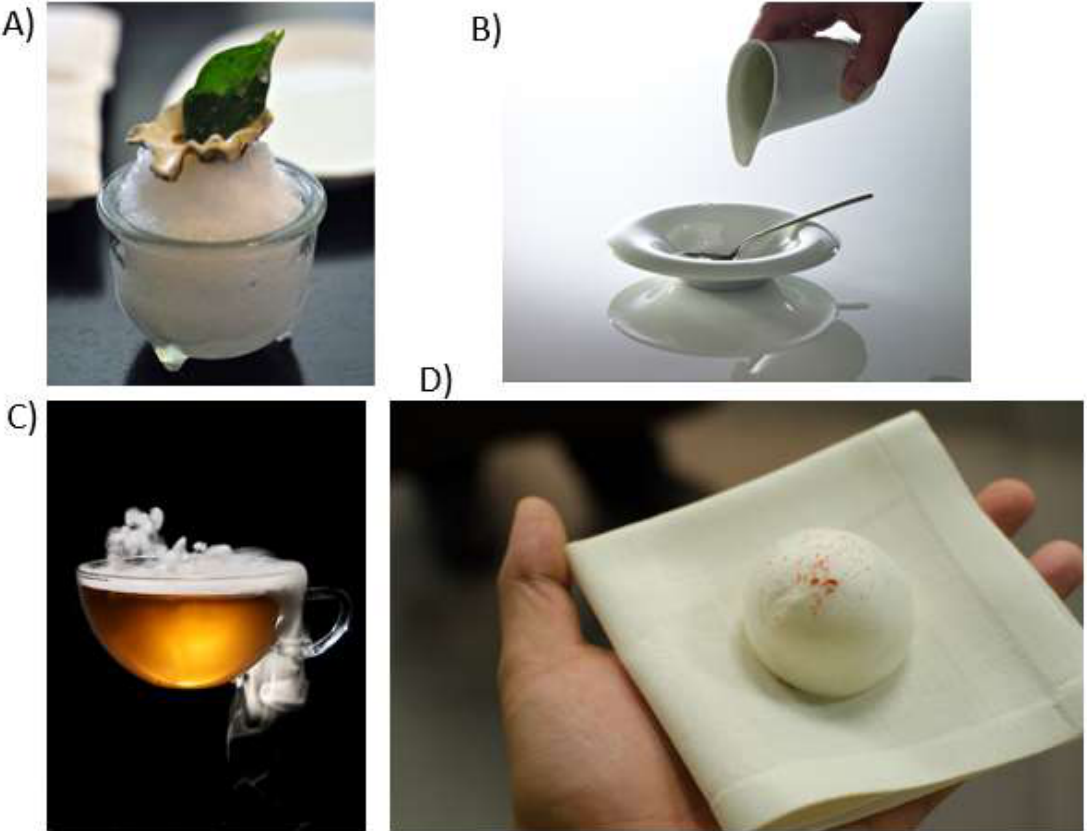
Figure 4. ( A ) Oyster leaf served as one of the courses at Grant Achatz’s Alinea restaurant in Chicago. This leaf tastes just like oyster; Diners may be left wondering ‘how on earth did the kitchen team manage to do that?’ while in fact, the leaf grows naturally on the shoreline (e.g., in Scotland; ( B ) ‘Rien’ the mysterious invisible dish by Denis Martin from the 2-Michelin starred namesake restaurant [74]; ( C ) The hot and iced tea as served at Heston Blumenthal’s The Fat Duck restaurant ([75]); ( D ) The ‘rattle’ from Mugaritz (c. 2014). But where does the noise come